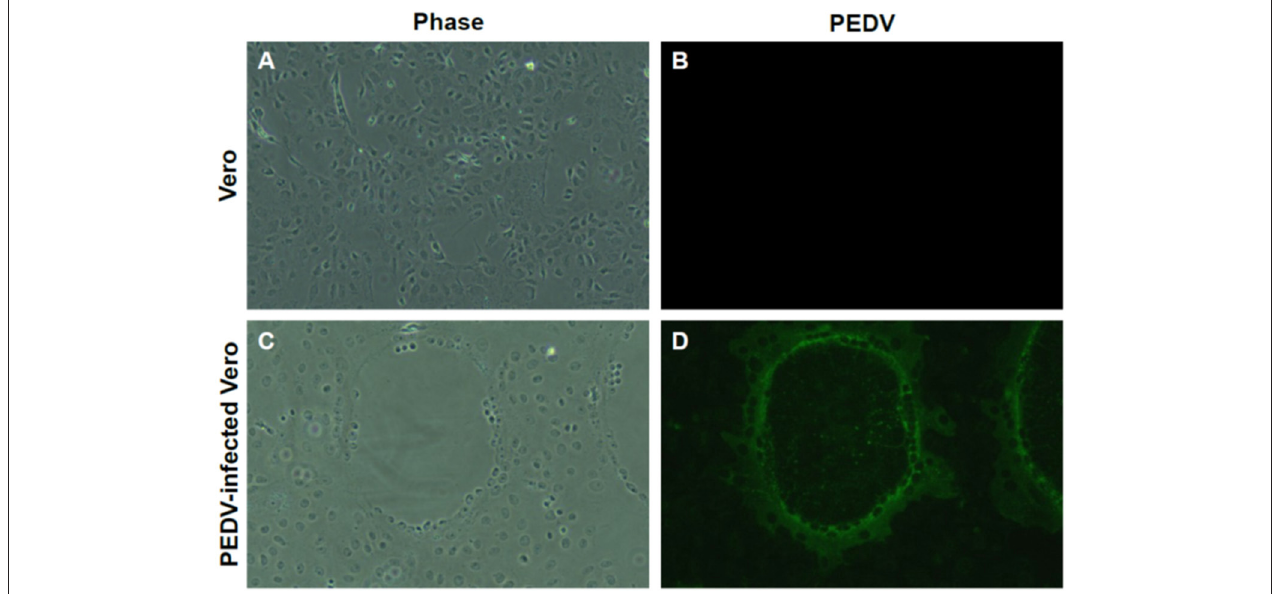
FIGURE 3 | Isolation of PEDV from umbilical cord. (A,B) Non-infected Vero cells. (C) Cytopathic effect (CPE) formation of newly isolated PEDV from the umbilical cord. Clear CPE formation like cell clumping and fusion was found in Vero cells infected with newly isolated. (D) Confirmation of PEDV infection by IFA. Confirmation of PEDV and its replication by IFA using PEDV-positive sera. Magnification, ×